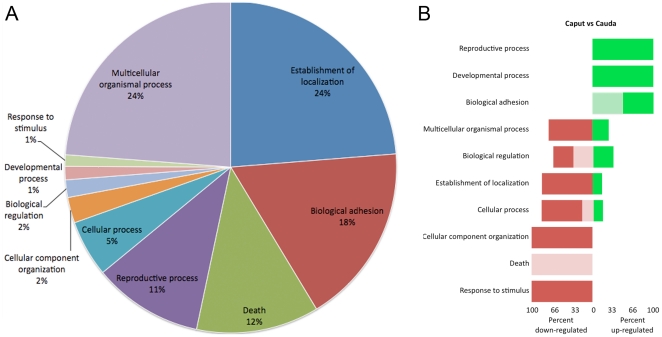
Categorization of predicted mRNA targets according to their GO terms.(A) Pie chart grouping predicted mRNA targets of miRNAs that significantly vary from one epididymal region to another (Fold change >2, p value<0.01). (B) Forest plot showing the categories of predicted mRNA targets that are significantly up or down regulated between the caput and cauda epididymidis (P value≤0.001). Light colors: miRNAs populations with a fold change ranging from 2 to 4. Dark colors: miRNAs populations with a fold change above 4.